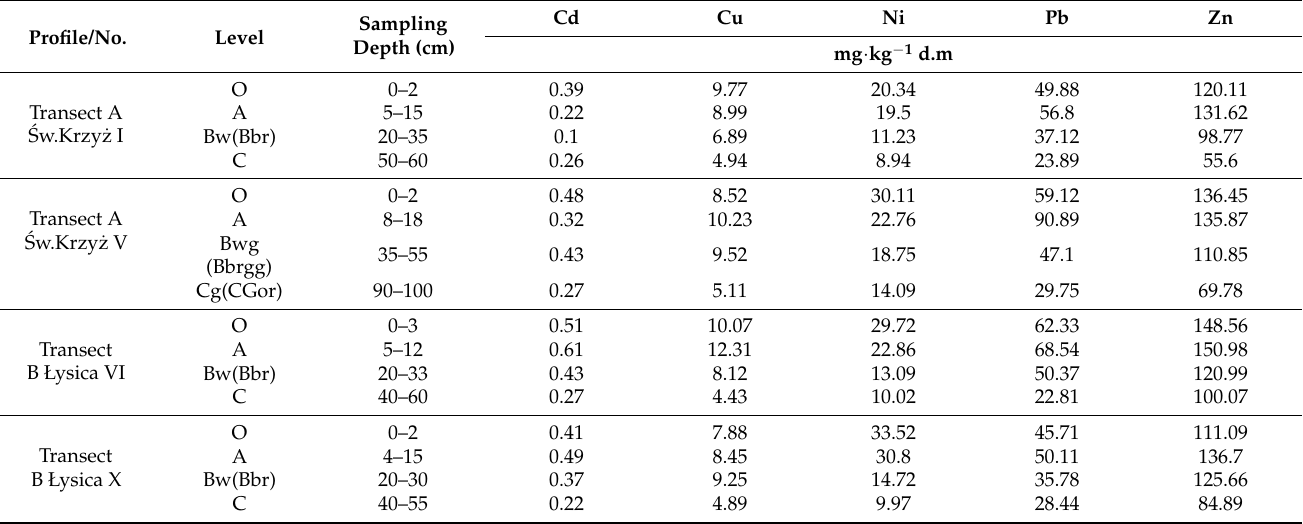
Table 3. Heavy metal concentrations in soils under silver fir growing in ´Swi˛etokrzyski National Park (mean).